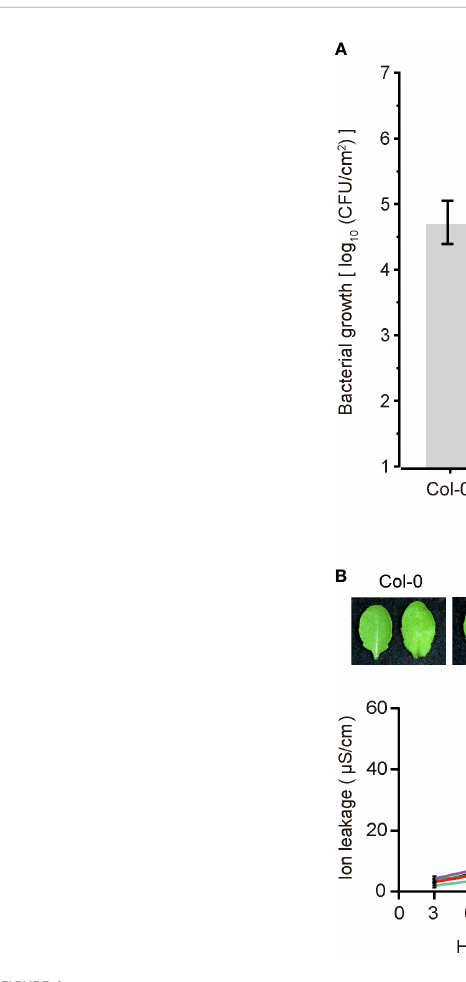
FIGURE 4 ECT9 and ECT1 play a negative role in resistance to Psm ES4326 (AvrRpt2). (A) Psm ES4326 (AvrRpt2) was in fi ltrated into Arabidopsis leaves at OD 600 nm = 0.001. Bacterial growth was determined at 3 dpi (mean ± SD; n = 7). Data were analyzed using one-way ANOVA with Dunnett ’ s test. dpi, days post-inoculation. (B) Cell death in Col-0, ect1 , ect9 , ect1/9 , and rps2 mutants by photographs (top) and the conductivity assay